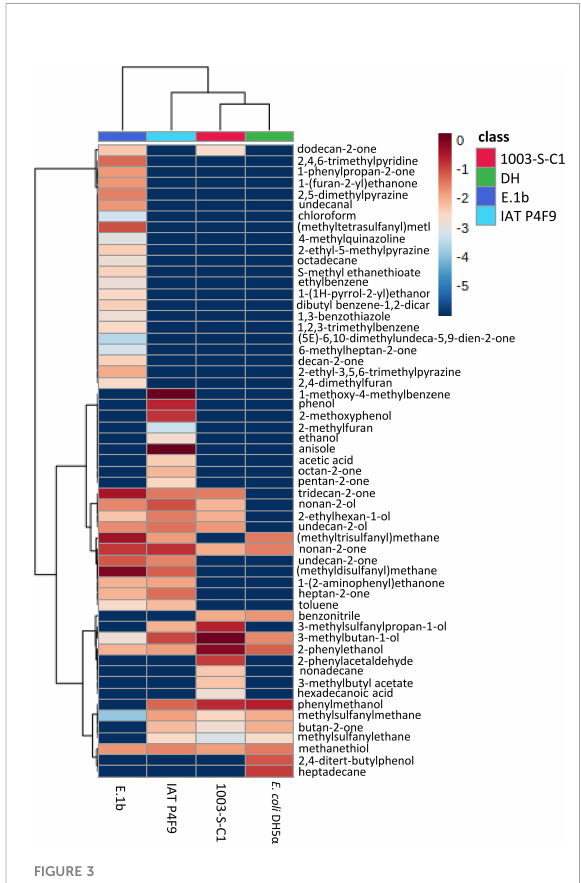
FIGURE 3 Heatmap of VOCs produced by the bacterial isolates (E.1b, IAT P4F9, and 1003-S-C1) and E. coli DH5 a grown in LB medium. Columns represent each bacterium and rows represent the different VOCs detected. The color code indicates the abundance of each compound (blue = low abundance; red = high abundance), based on the average of the Log 10 - transformed values (peak areas were normalized by cis-3- Hexenyl acetate) ( n = 5). The darkest blue indicates that the VOCs were not identi fi ed in the volatilome of the respective